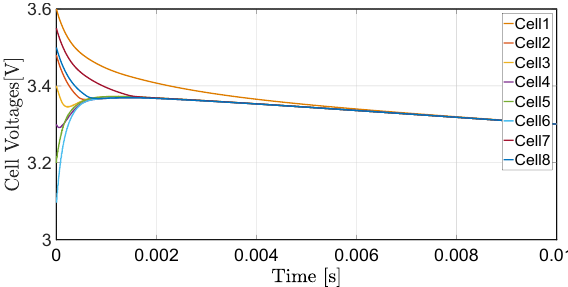
Figure 9. The simulation results of the proposed transformer balancing circuit with a load.